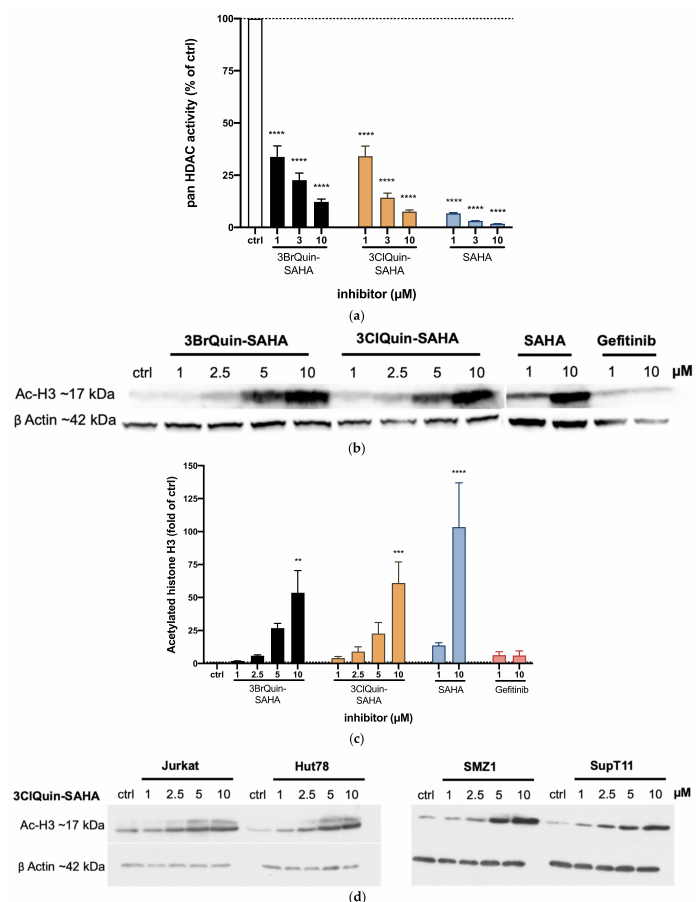
Figure 4. HDAC inhibitory effects of 3BrQuin-SAHA and 3ClQuin-SAHA. ( a ) HDAC activity was measured by luminescence display of the acetylation state of histones. HeLa nuclear cell extracts, used as source for histones, were preincubated with substrate and inhibitor. Results are given as relatives to controls, not preincubated with inhibitor, as means ± SEM of n = 3 independent experiment. ( b ) Representative Western blot out of n = 3 experiments, showing changes in the expression of acetylated histone H3 after 24 h treatment with compounds in DU145 cells. ( c ) Out of the DU145 Western blots’ gray intensity, mean ± SEM of acetylated histone-H3-specific bands were quantified, adjusted to protein-loading, and normalized to untreated control. ( d ) Western blots, showing changes in the expression of acetylated histone H3 after 24 h treatment with 3ClQuin-SAHA in Jurkat, Hut78, SupT11, andSMZ1 human T-cell leukemia/lymphoma cell lines. ** p ≤ 0.005, *** p ≤ 0.0005, **** p ≤ 0.0001; two-way ANOVA Dunnett’s post hoc